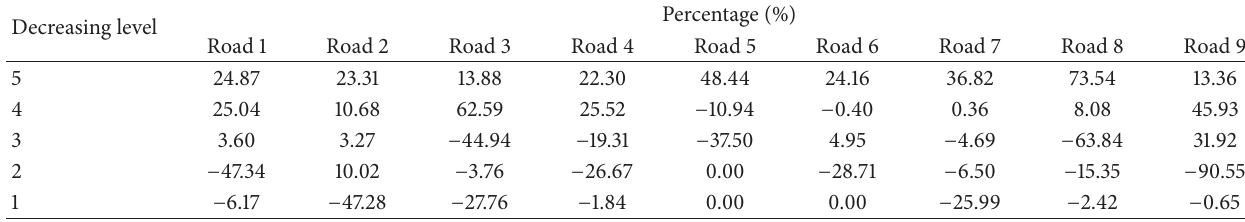
Table 12: Safety risk level difference results for all users with countermeasures